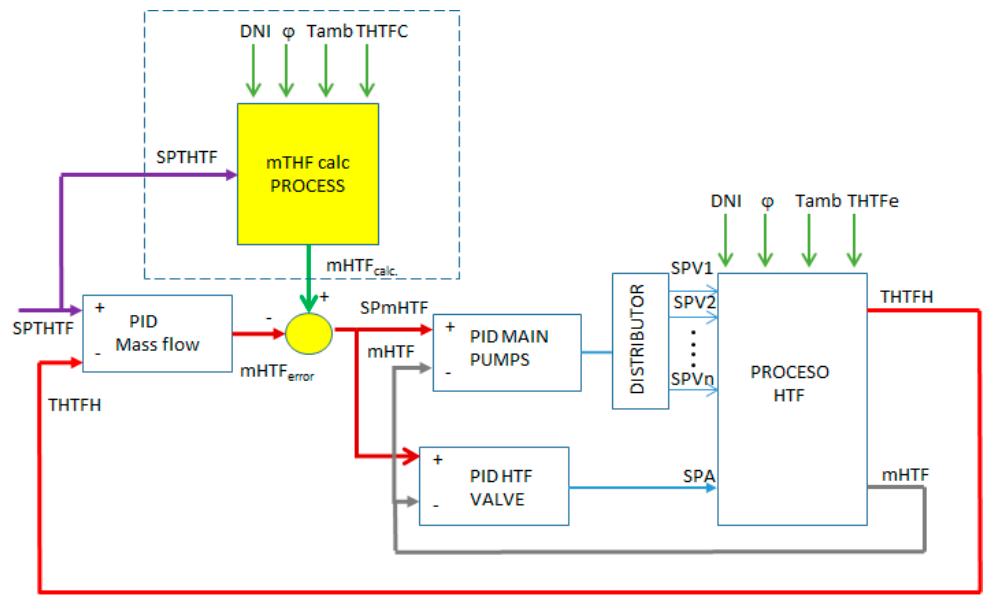
Figure 4. Block diagram of the process, with the feed-forward implemented.